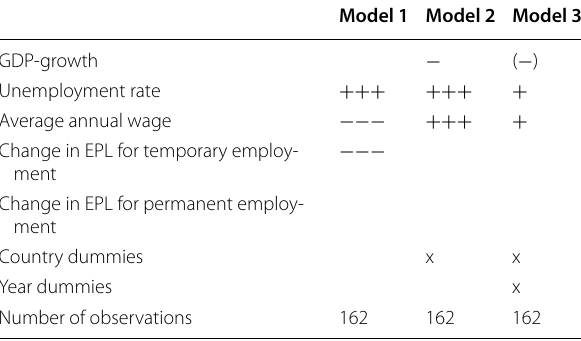
Table 2 Regression results: share of temporary employed. Source Eurostat LFS (2016), Eurostat Database (2016) and OECD.Stat (2016), own calculations